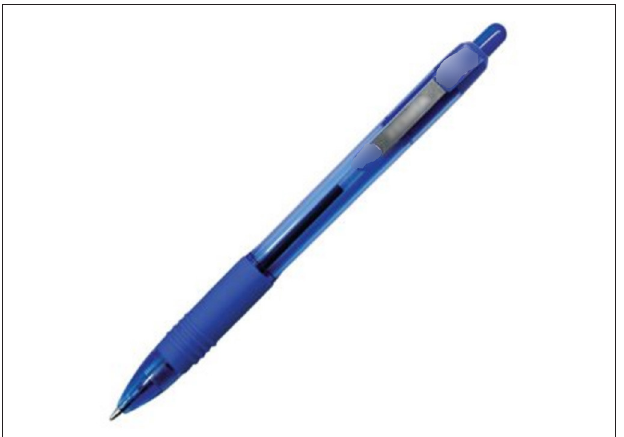
FIGURE 1 | The Bic pain used for object A in WCF, WCK, and KCF conditions. objects that are strongly prototypical of objects used during the custom ceremony.